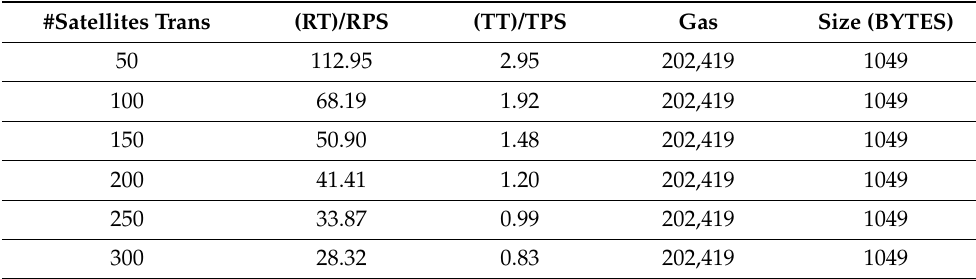
Table 5. Results of the impact of the transactional data size 2049 bytes on RT, and TT according to the number of satellite transactions.